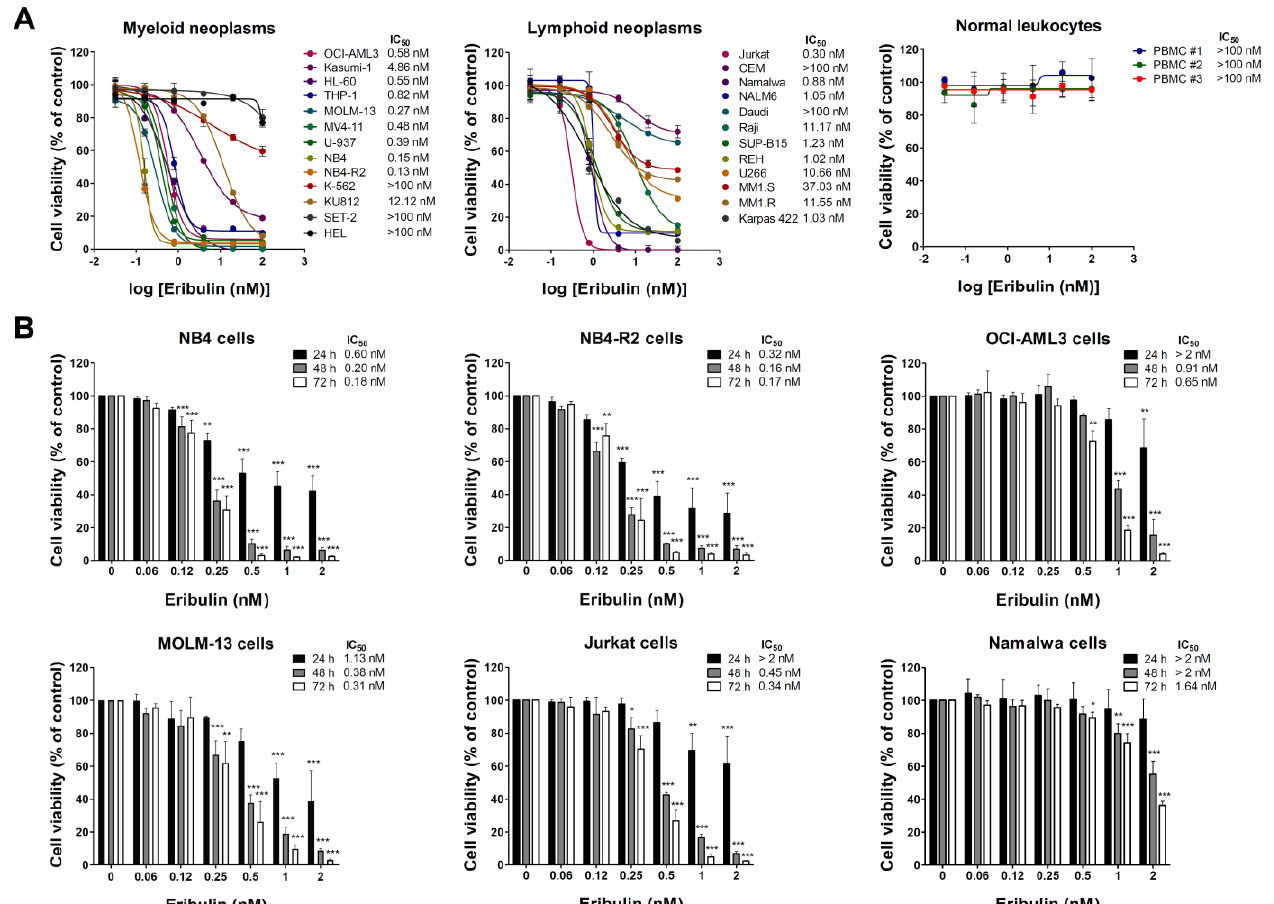
Figure 1. Eribulin exhibits selective dose- and time-dependent cytotoxic activity in blood cancer cells. ( A ) Dose – response curves were analyzed by methylthiazoletrazolium (MTT) assay in a panel of myeloid and lymphoid neoplasms cells or peripheral blood mononuclear cells (PBMC) from three healthy donors treated with increasing concentrations of eribulin (0.032 – 100 nM) for 72 h. We note that at the concentrations tested, the IC 50 was not achieved (>100 nM) in normal leukocytes. ( B ) Bar graphs represent dose- and time-dependent responses to eribulin (0.06 – 2 nM) after 24, 48, and 72 h of exposure in NB4, NB4-R2, OCI-AML3, MOLM-13, Jurkat, and Namalwa cells. Values are ex- pressed as the percentage of viable cells for each condition relative to untreated controls. Results are presented as mean ± SD of at least four independent experiments. The p values and cell lines are indicated in the graphs; * p < 0.05, ** p < 0.01, *** p < 0.001; ANOVA test and Bonferroni post-test.